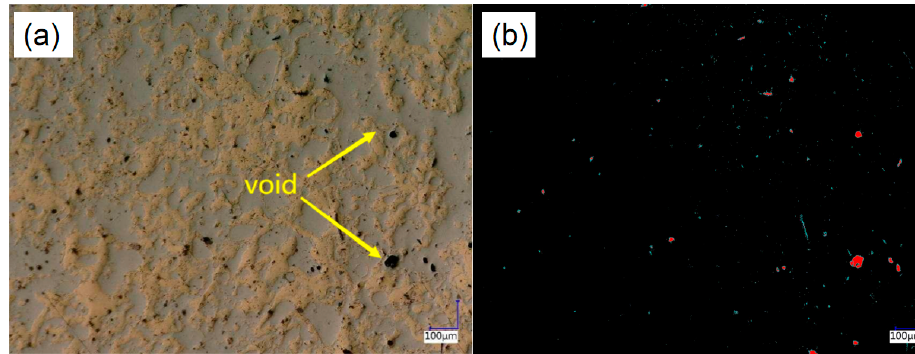
Figure 9. ( a ) 3D topography of the surface of the coating; ( b ) comparison chart of porosity. Table 4. Calculation of porosity of the coating.